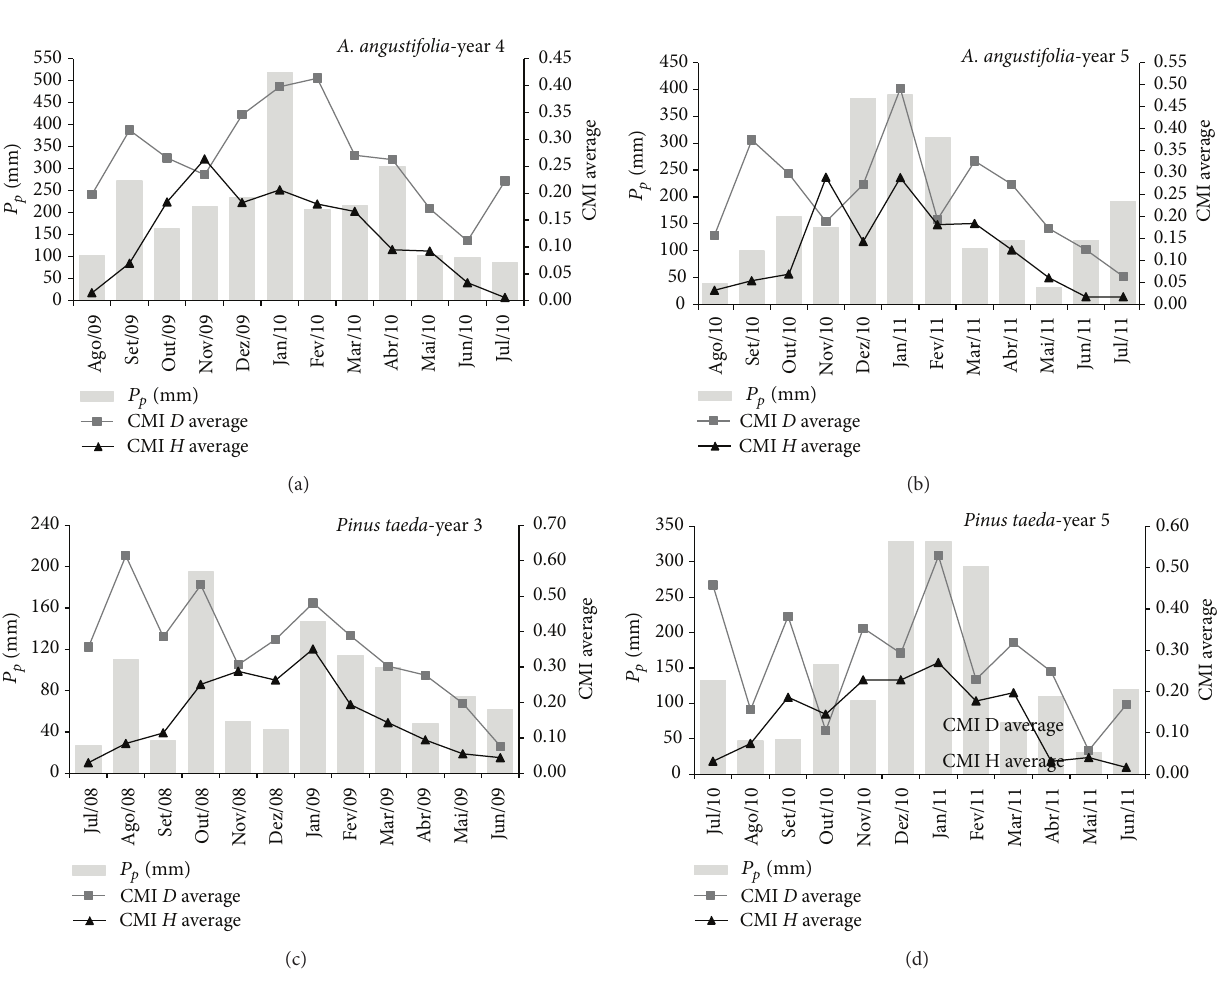
Figure 1: Correlation between the current monthly increments (CMI) in diameter (cm) and height (m) with the climate precipitation variable ( 𝑃 𝑝 ) in plantings of Araucaria angustifolia and Pinus taeda